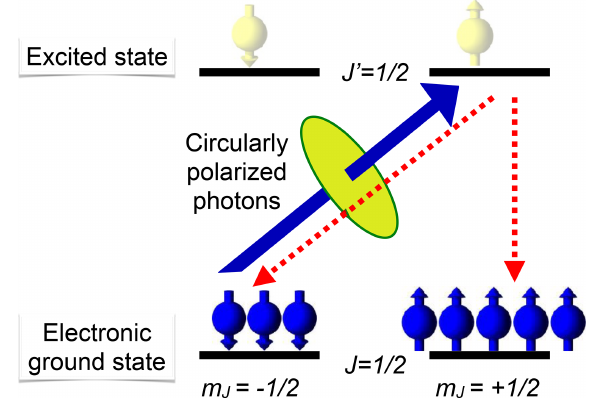
Figure 4. Basic principle of optical pumping. The solid arrow indi- cates the only transition that couples to a circularly polarized laser field in this level system. The dashed arrows indicate transitions for spontaneous